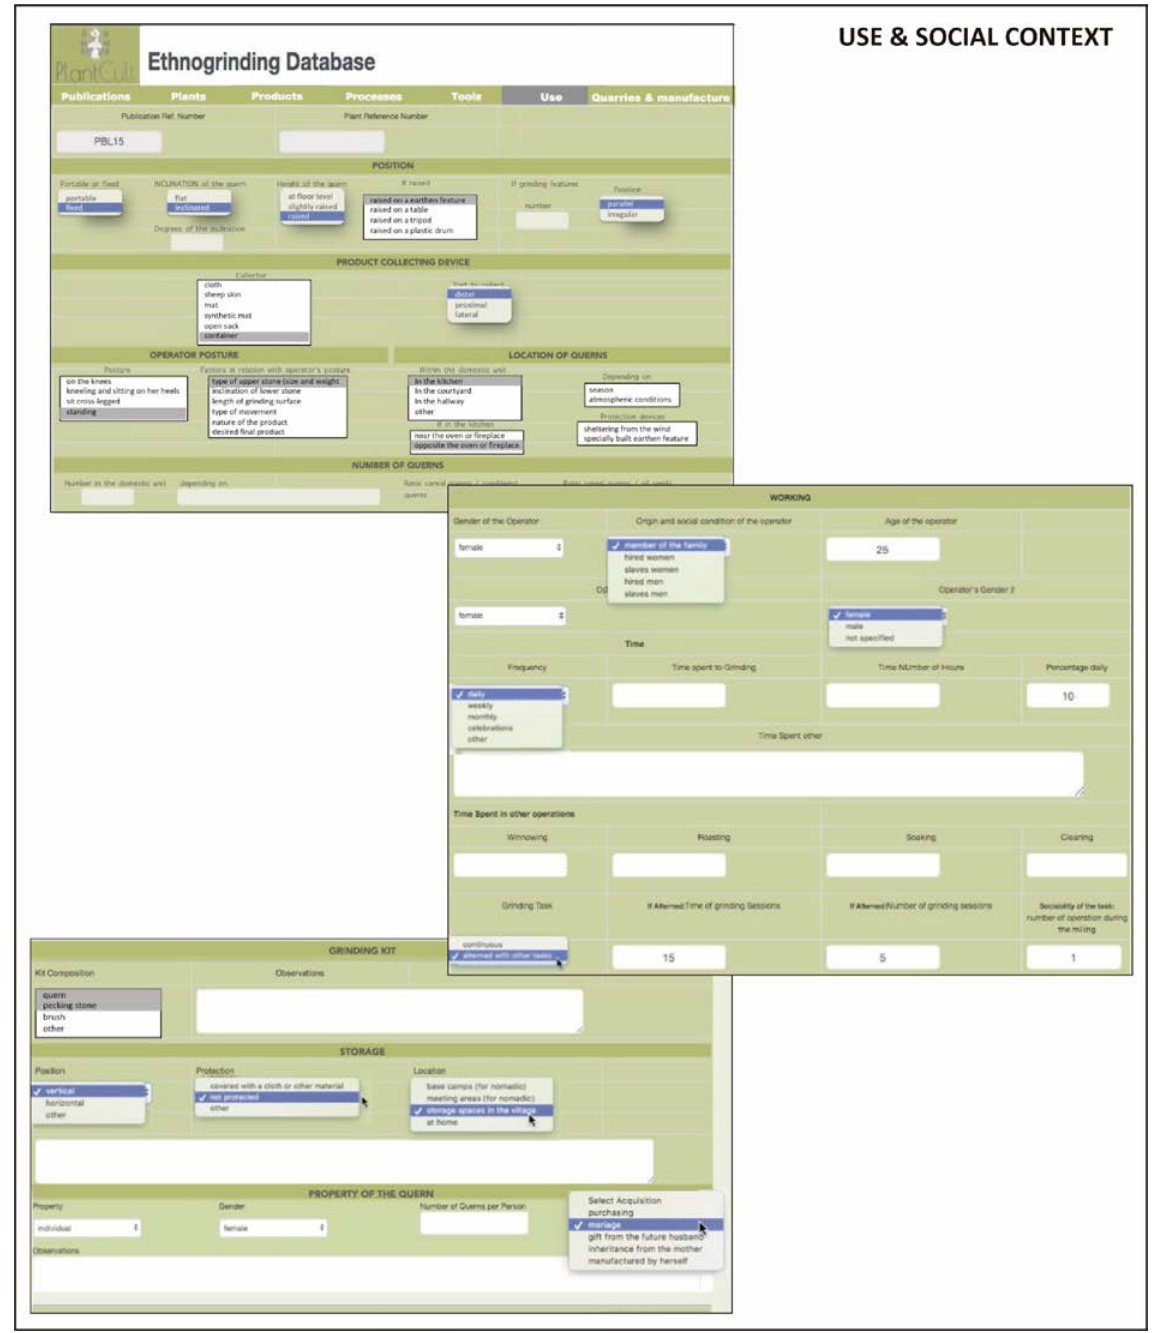
Figure 8. The Use